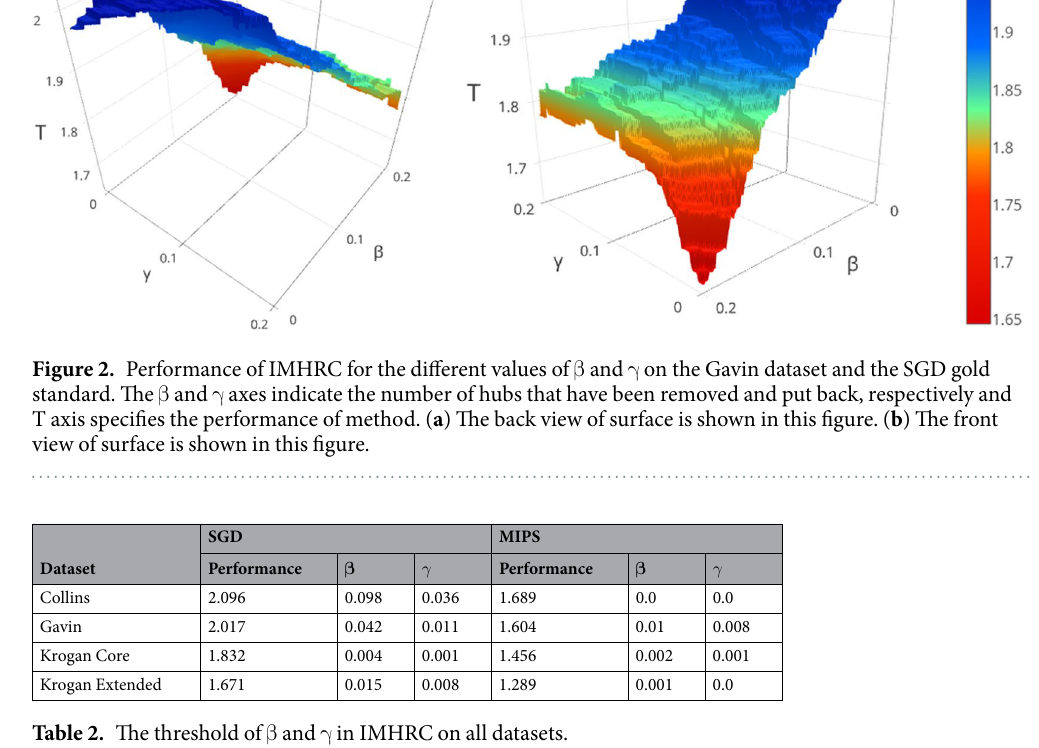
Table 2. The threshold of β and γ in IMHRC on all